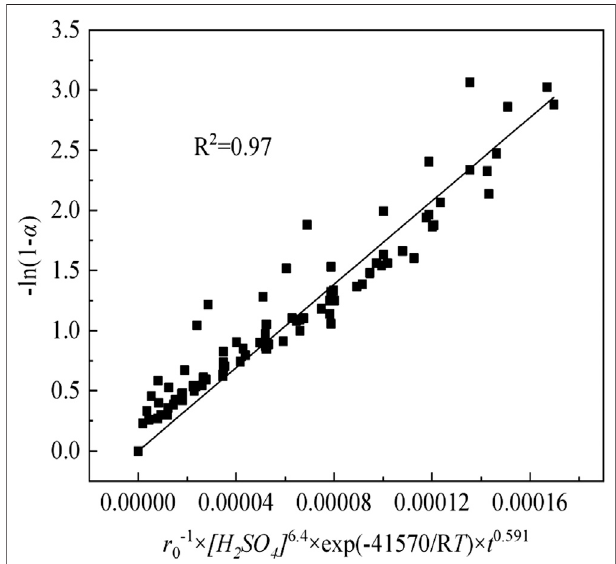
FIGURE 14 | The relationships of sulfuric acid curing between -ln(1- α ) and